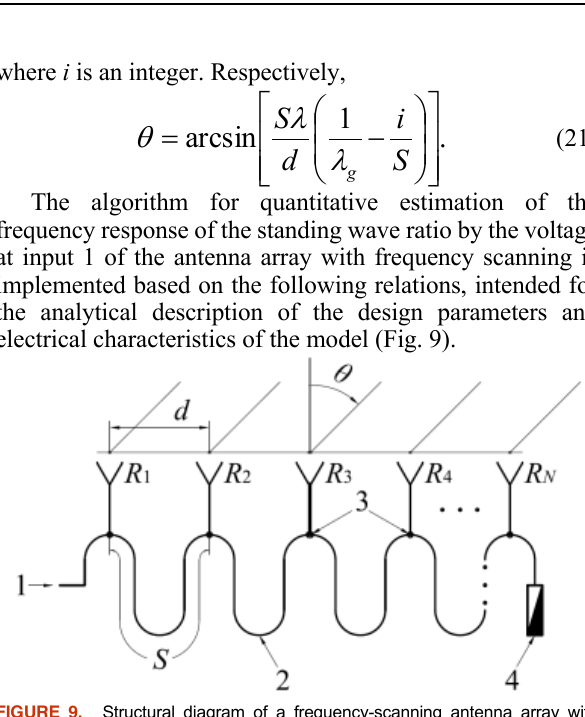
FIGURE 9. Structural diagram of a frequency-scanning antenna array with serially fed